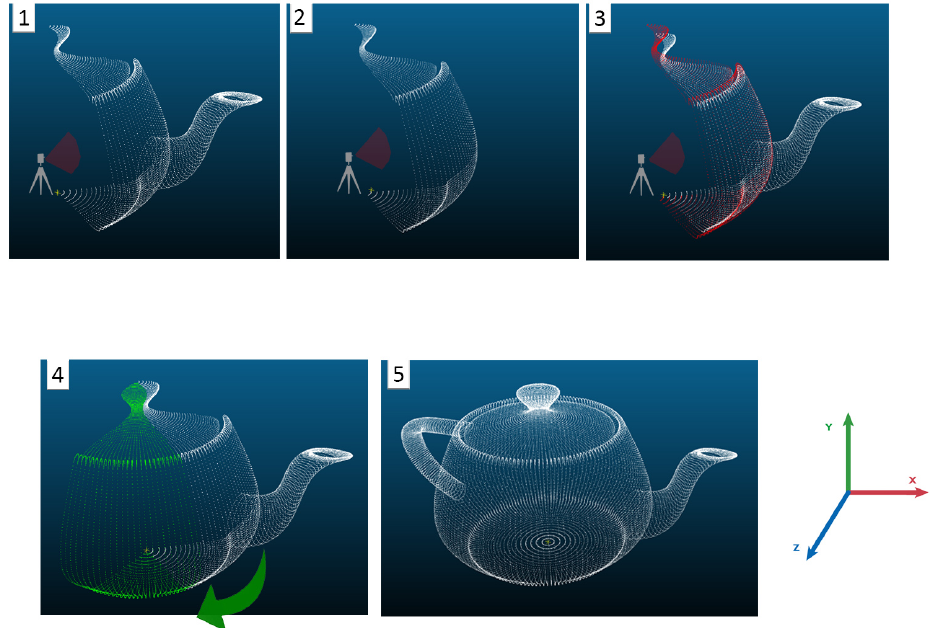
Figure 3. Steps to align the final. This is a synthetic example assuming that the lidar is located in the centre of the teapot point cloud.